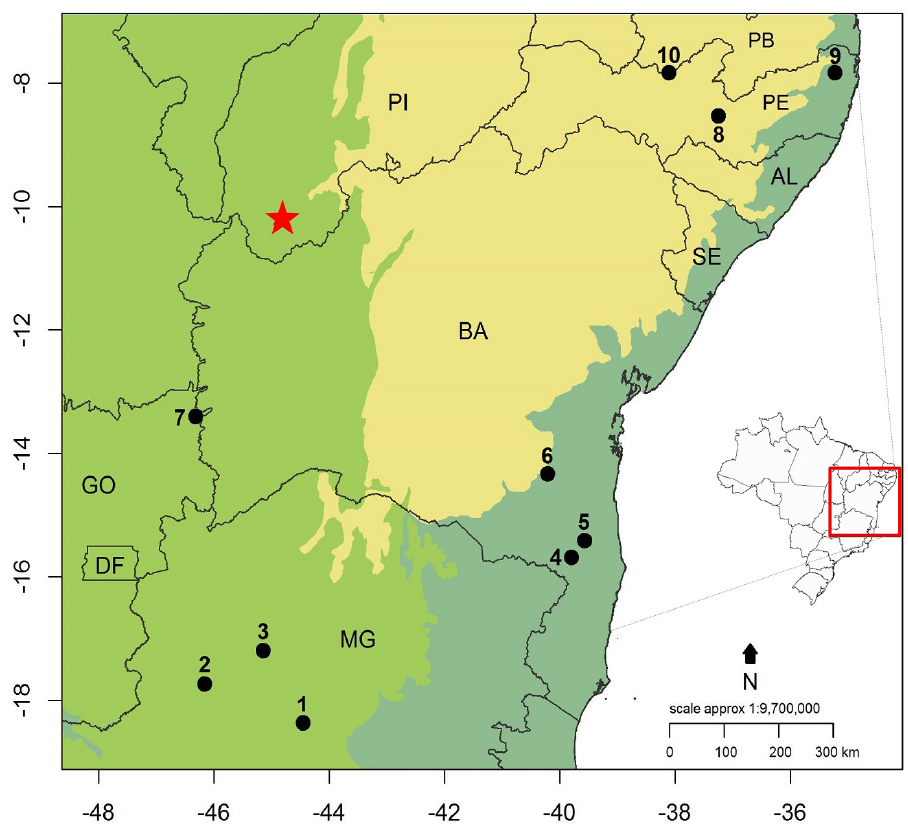
Figure 2. Geographic distribution of Trachycephalus nigromaculatus . Previous records in the last review on literature data (black circles), New record (red star). State abbreviations: MG = Minas Gerais, GO = Goiás, BA = Bahia, SE = Sergipe, AL = Alagoas, PE = Pernambuco, PB = Paraíba, PI = Piauí. Municipalities: 1 = Corinto (Cintra et al. 2009), 2 = João Pinheiro (Silveira 2006), 3 = Buritizeiro (Cintra et al. 2009), 4 = Potiraguá (Freitas 2009), 5 = Camacan (Dias et al. 2016), 6 = Boa Nova (Dias et al. 2016), 7 = São Domingos (Cintra et al. 2009), 8 = Buíque (Moura et al. 2011), 9 = Igarassu (Moura et al. 2011), 10 = Triunfo (Moura et al. 2011). Latest new record in red star: Riacho